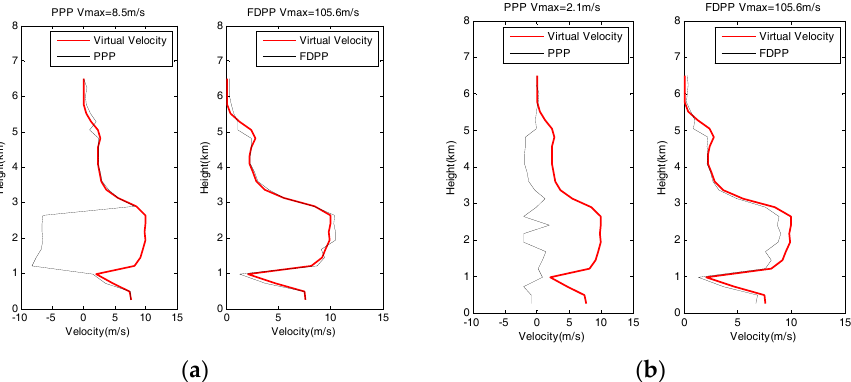
Figure 8. FDPP velocity estimation and dealiasing results. ( a ) Comparison between FDPP and PPP velocity estimation results when PRF is 4000 Hz: the maximum unambiguous velocity is 8.5 m/s with PPP and 105.6 m/s with FDPP. The black line represents the estimation results; ( b ) Comparison between FDPP and PPP velocity estimation results when PRF is 1000 Hz. To verify that the selection of PRF in the FDPP algorithm has no direct effect on the maximum unambiguity velocity, the PRF was adjusted to satisfy the maximum unambiguity distance. We adjusted the PRF to 1000 Hz, resulting in a maximum unambiguous velocity with PPP estimation algorithm of 2.1 m/s, and a maximum unambiguous velocity with FDPP estimation algorithm of 105.6 m/s. From Figure 8b, the velocity of the traditional PPP method always has ambiguous velocity, and then the FDPP estimation results are acceptable.